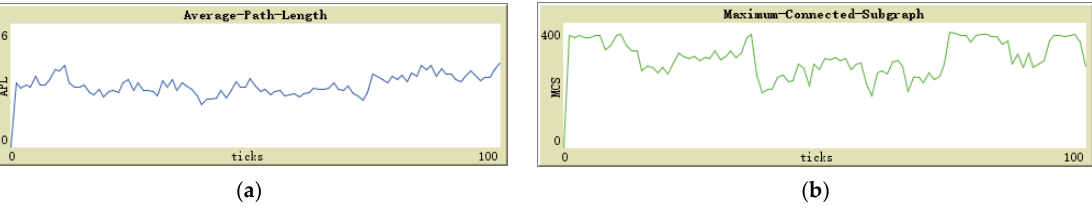
Figure 7. ( a ) APL trend without global maintenance; ( b ) MCS trend without global maintenance.